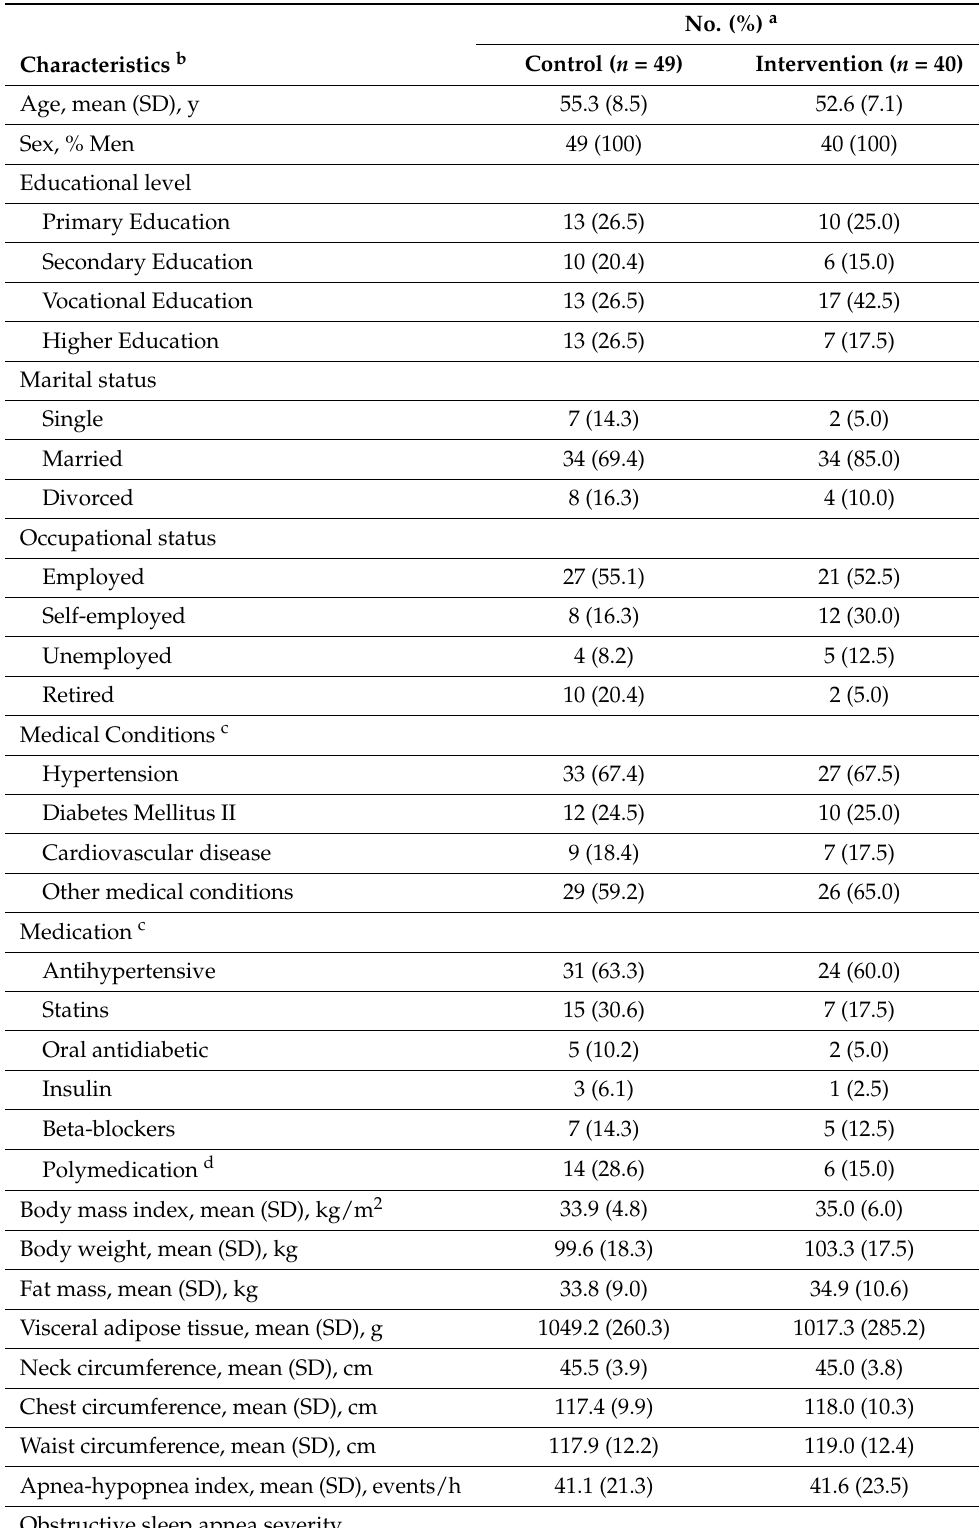
Table 1. Baseline characteristics of the study